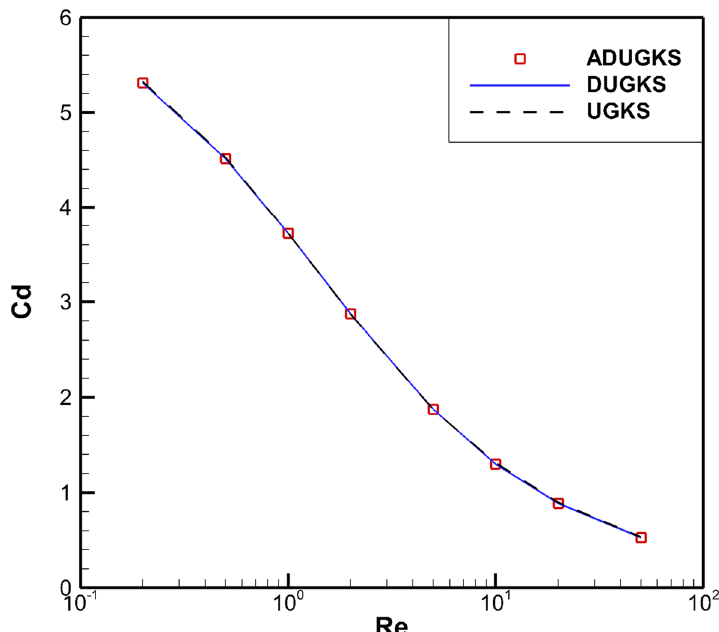
Fig. 8 Drag coefficient of the flat plate with respect to the Reynolds number in the transition and slip flow regimes